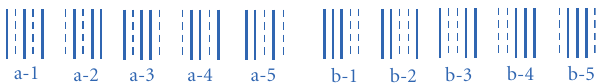
Figure 3: All unit arrangements of electron configurations for ν = 3 /